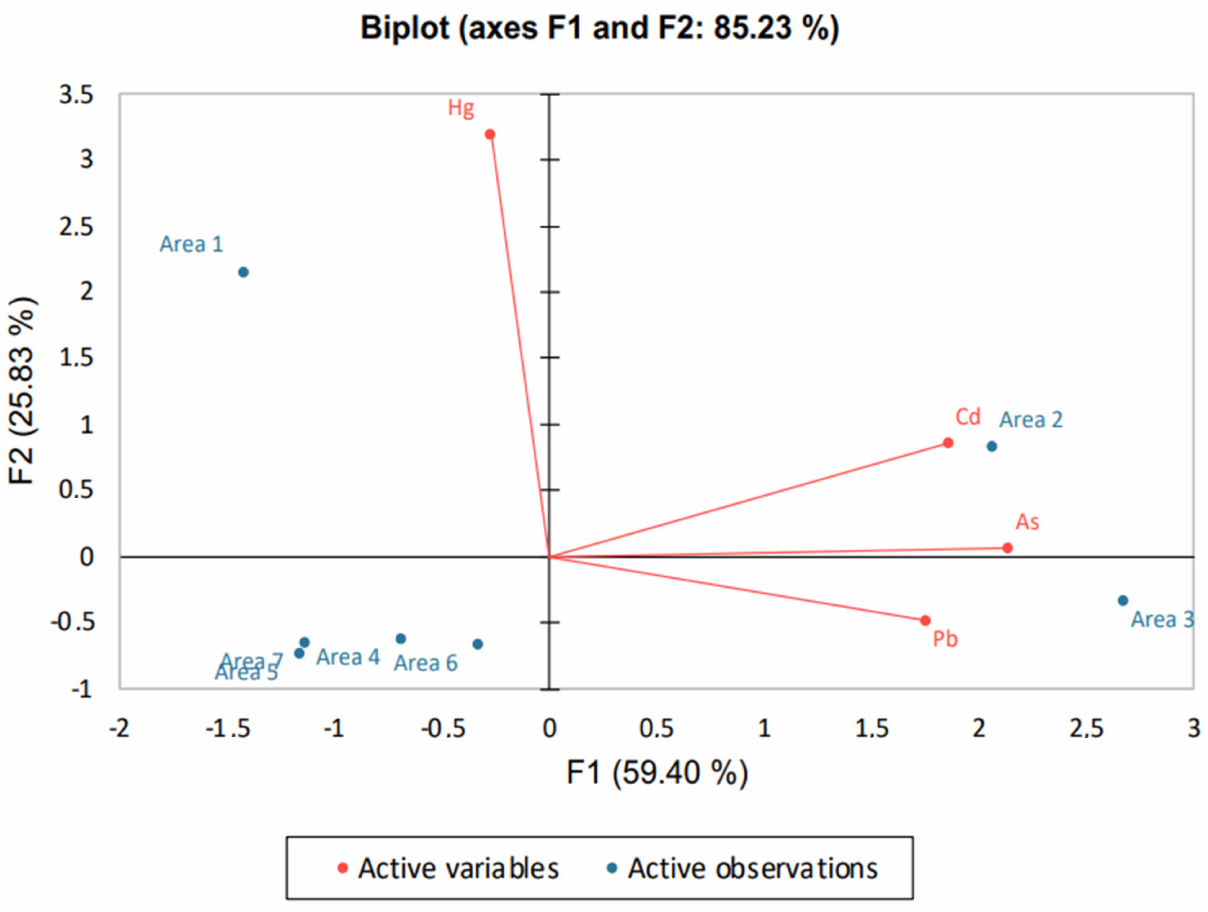
Figure 3. PCA biplot produced for toxic trace elements on